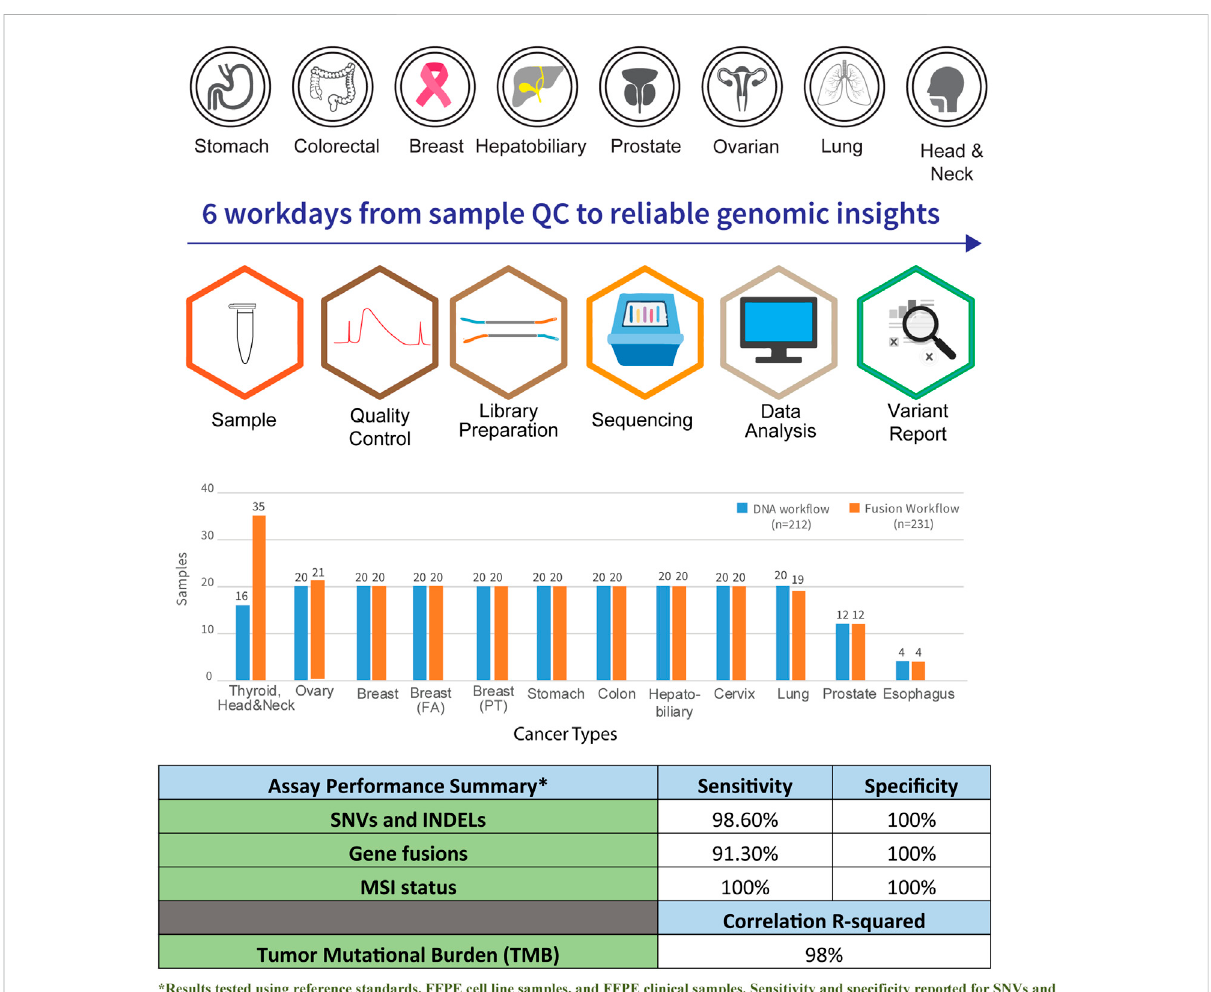
FIGURE 1 Graphical overview of work fl ow and coverage of cancer subtypes in the Asian Pan-Cancer Panel. A total of six workdays are required from sampleQCtoreliablegenomicinsights.Totalnumberofsamplespro fi ledacrossthevariouscancersubtypesandassayperformancesummaryareas